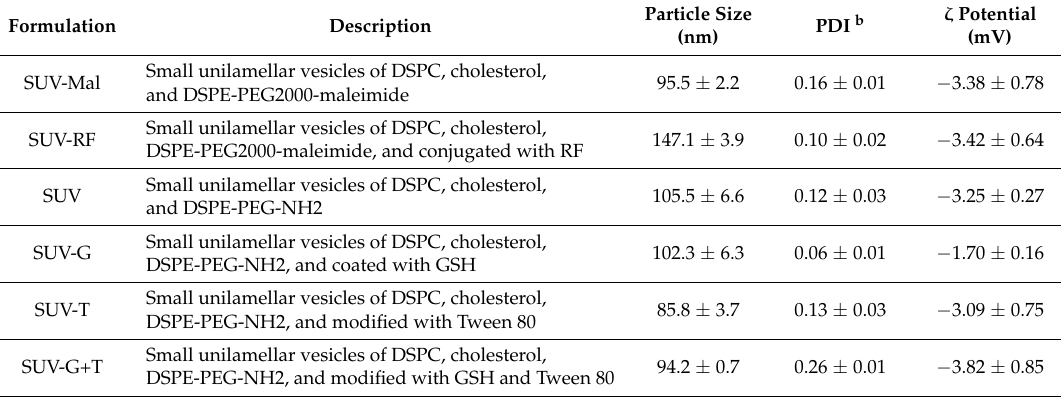
Table 1. Characterization of gefitinib-loaded liposomes modified with glutathione (GSH), Tween 80, or RF a . Formulation